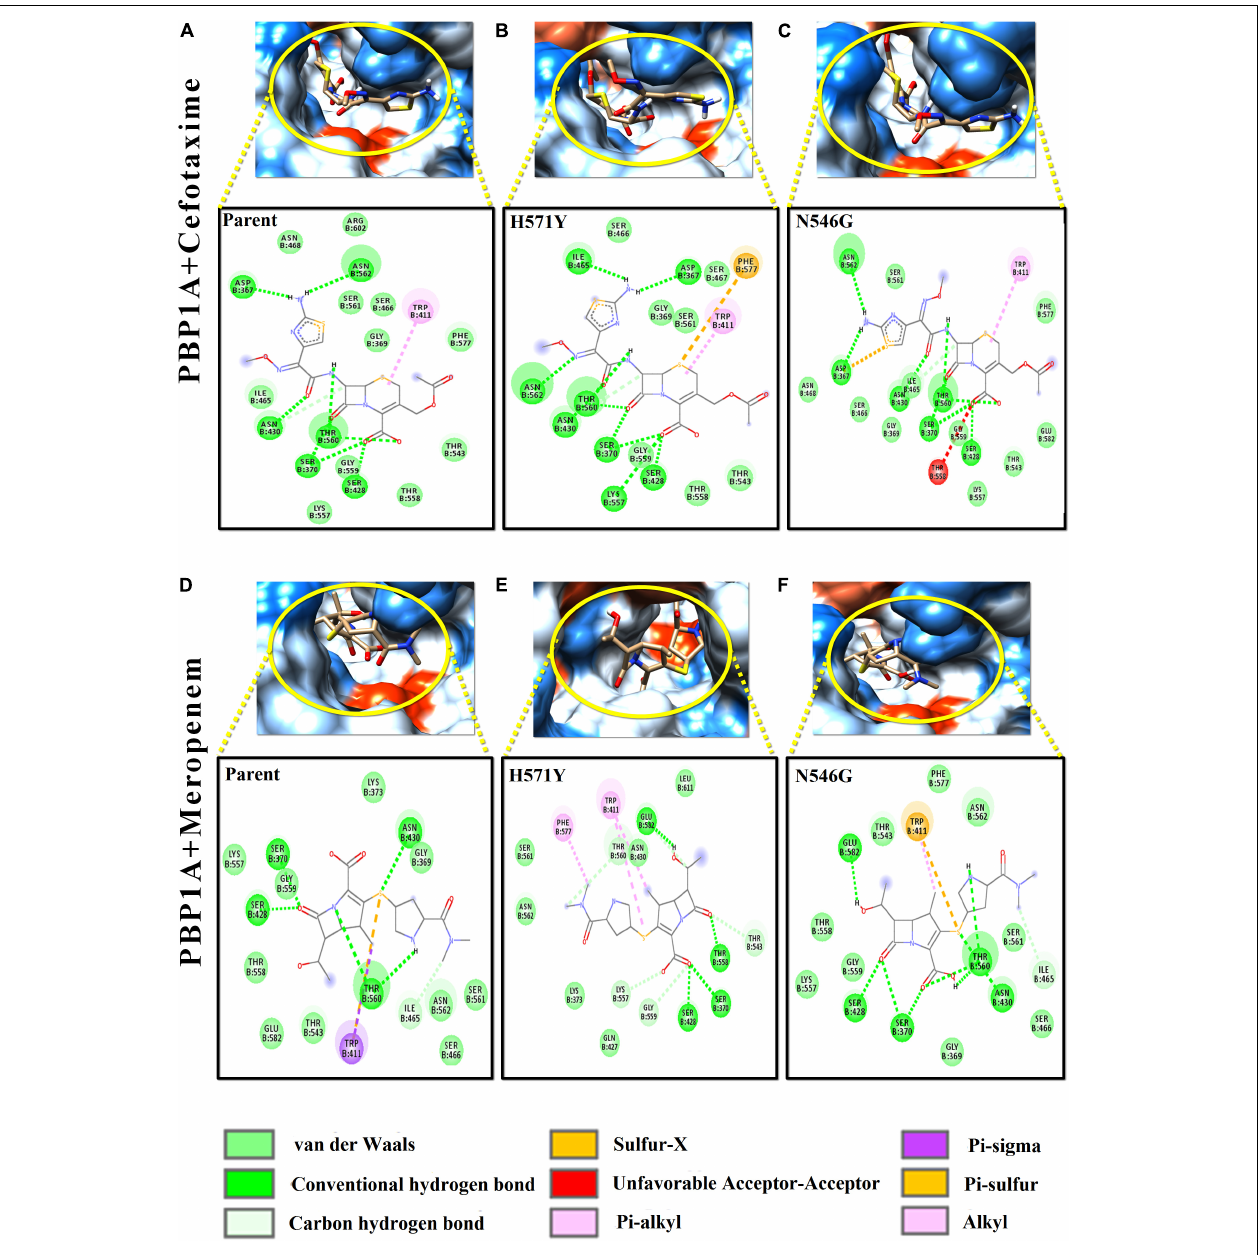
FIGURE 4 | Intermolecular interactions of PBP1A with cefotaxime and meropenem. (A) PBP1A (parent) + cefotaxime, (B) PBP1A (H571Y) + cefotaxime, (C) PBP1A (N546G) + cefotaxime, (D) PBP1A (parent) + meropenem, ( E ) PBP1A (H571Y) + meropenem, and (F) PBP1A (N546G) + meropenem.